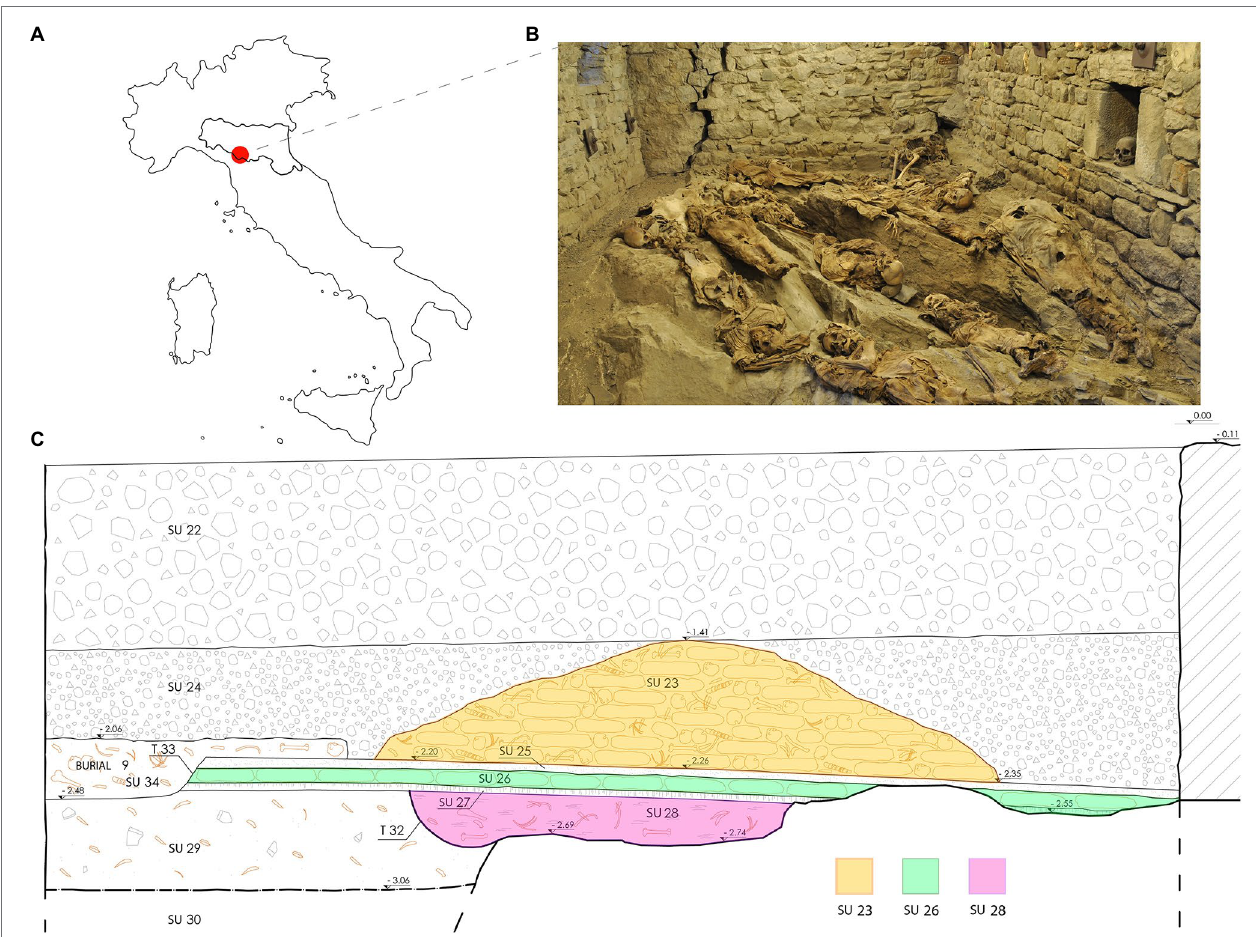
FIGURE 1 | (A) The geographical location of Roccapelago; (B) an image of the current musealization inside the crypt; (C) graphical section of the stratigraphic units (SU) of the Roccapelago crypt. The SU interested by the sampling are labeled with different colors. Modified from the original illustration made by Alessandra